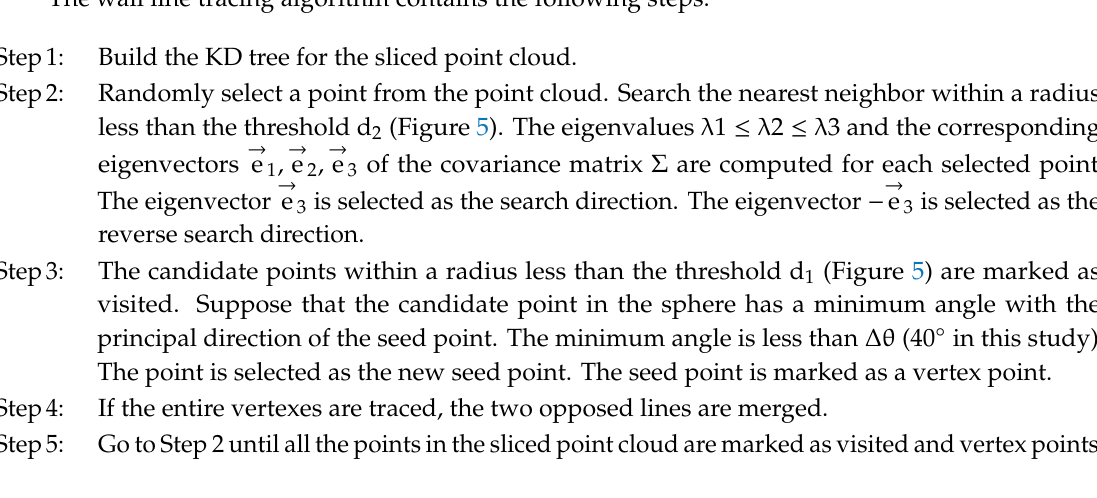
Figure 4. The sliced point cloud is thinned by the mean-shift algorithm.